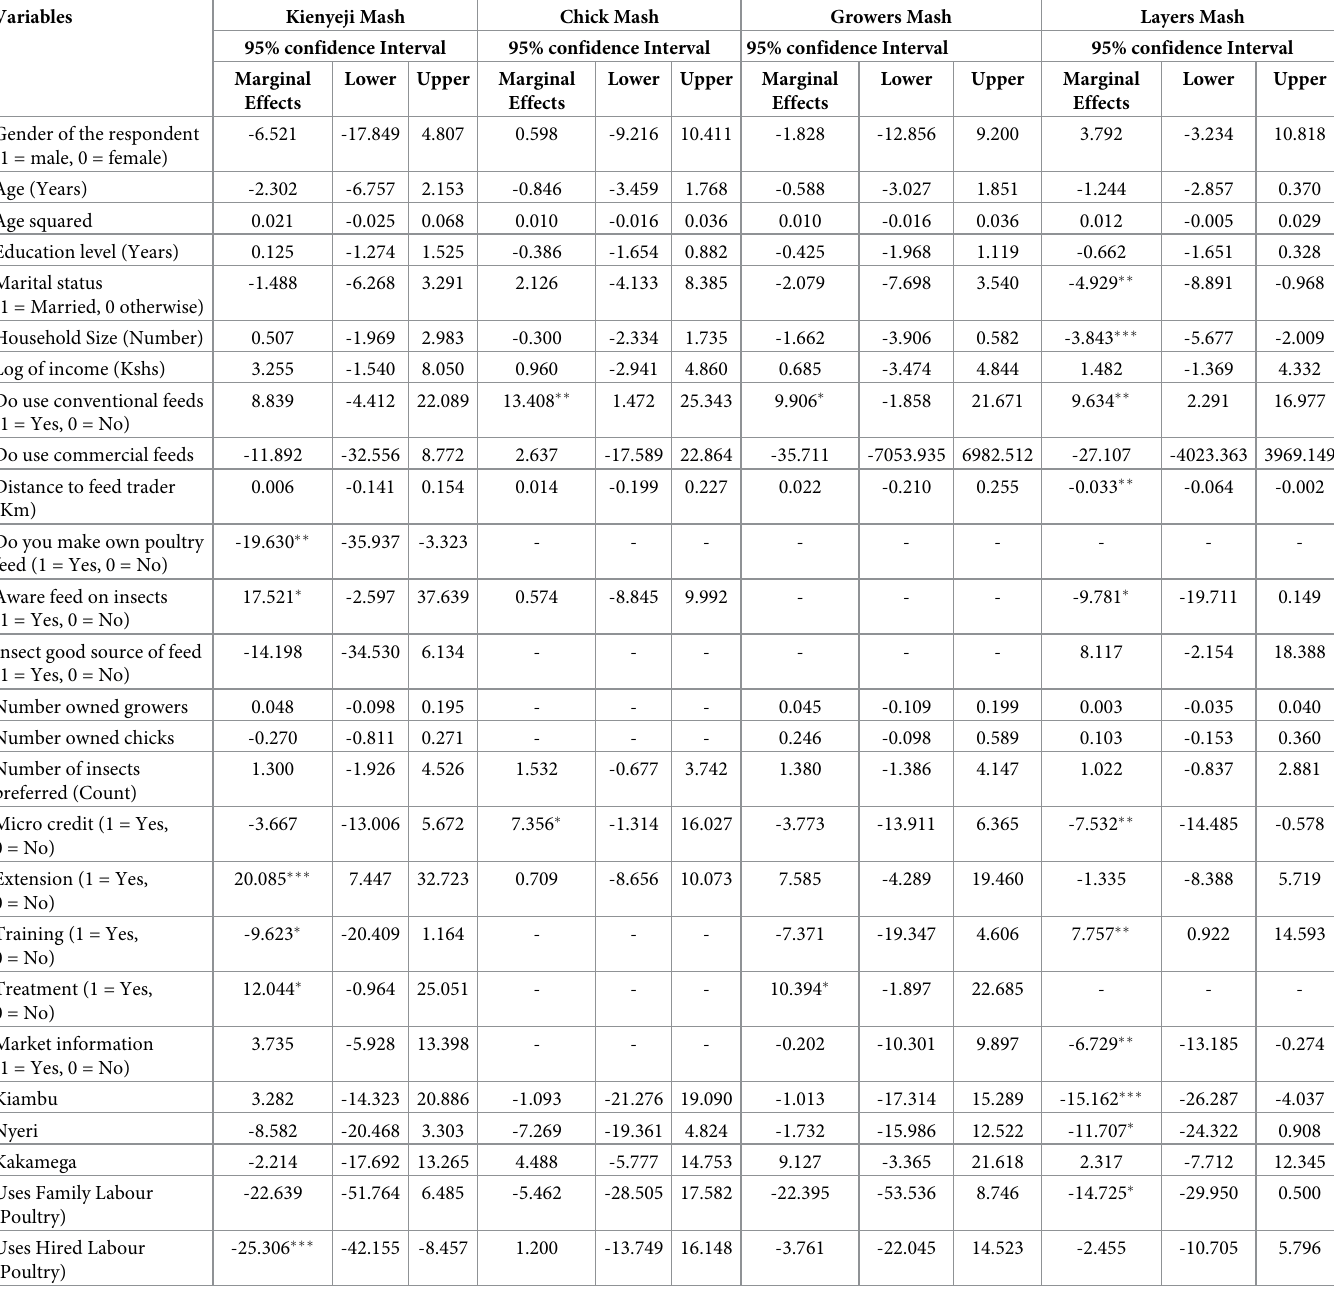
Table 6. Regression results for factors influencing willingness to pay (WTP) for insect-based feeds among poultry farmers.